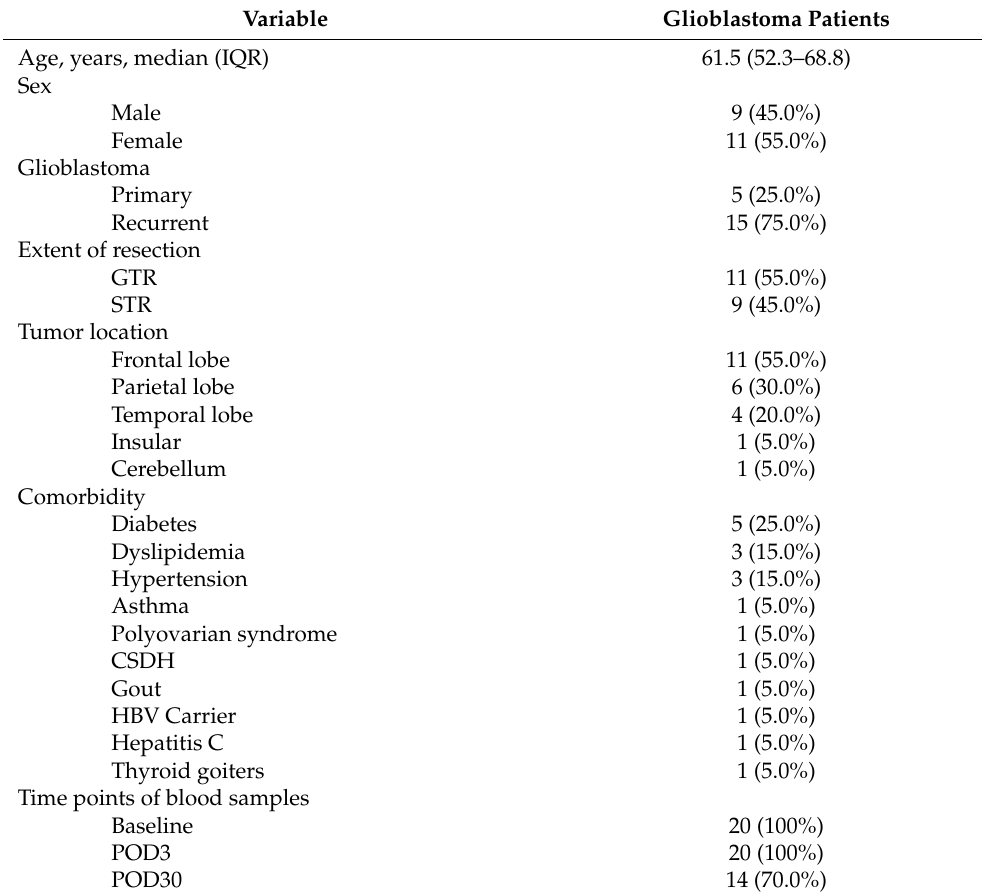
Table 1. Baseline demographic and clinical characteristics of glioblastoma patients (N =